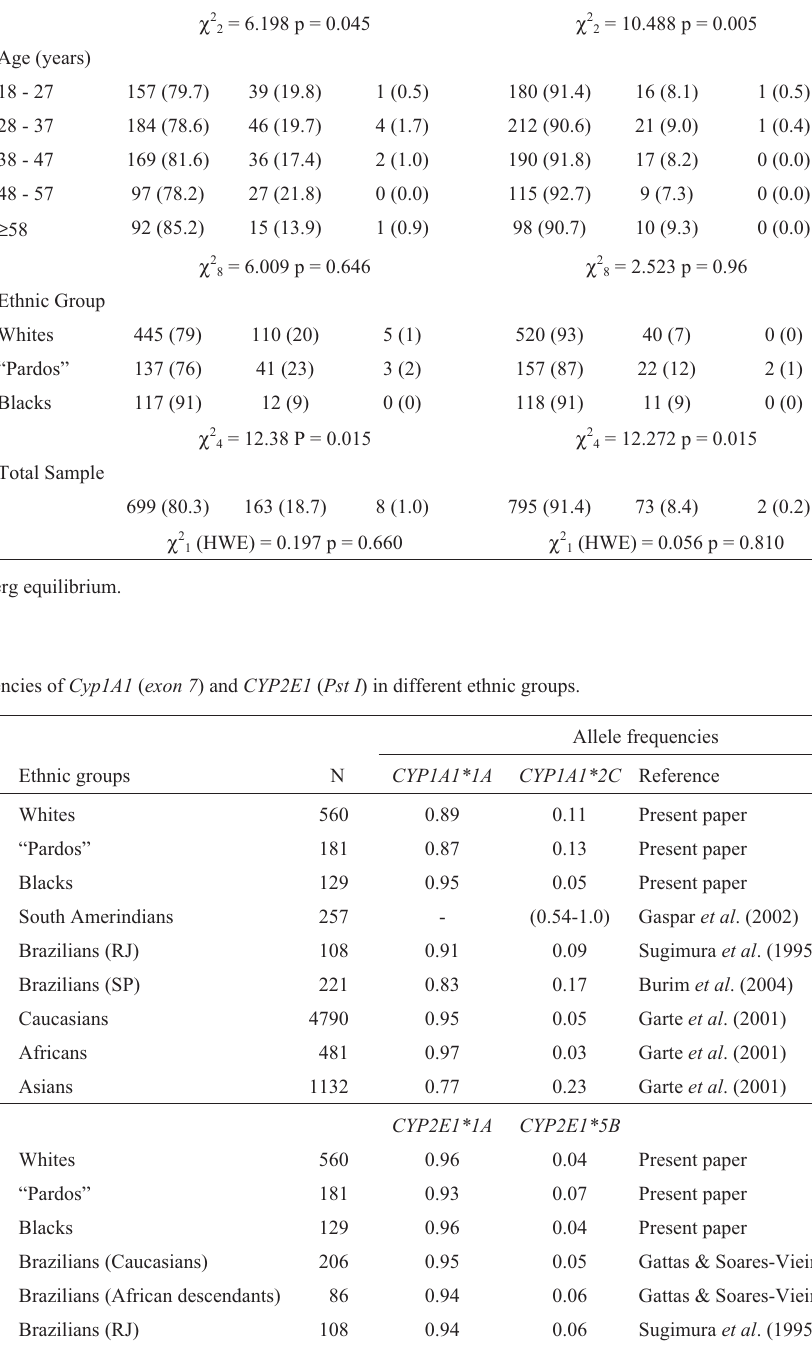
Table 1 - Distribution of genotypes CYP1A1 and CYP2E1 according to sex, age and ethnicity in a Rio de Janeiro population sample.